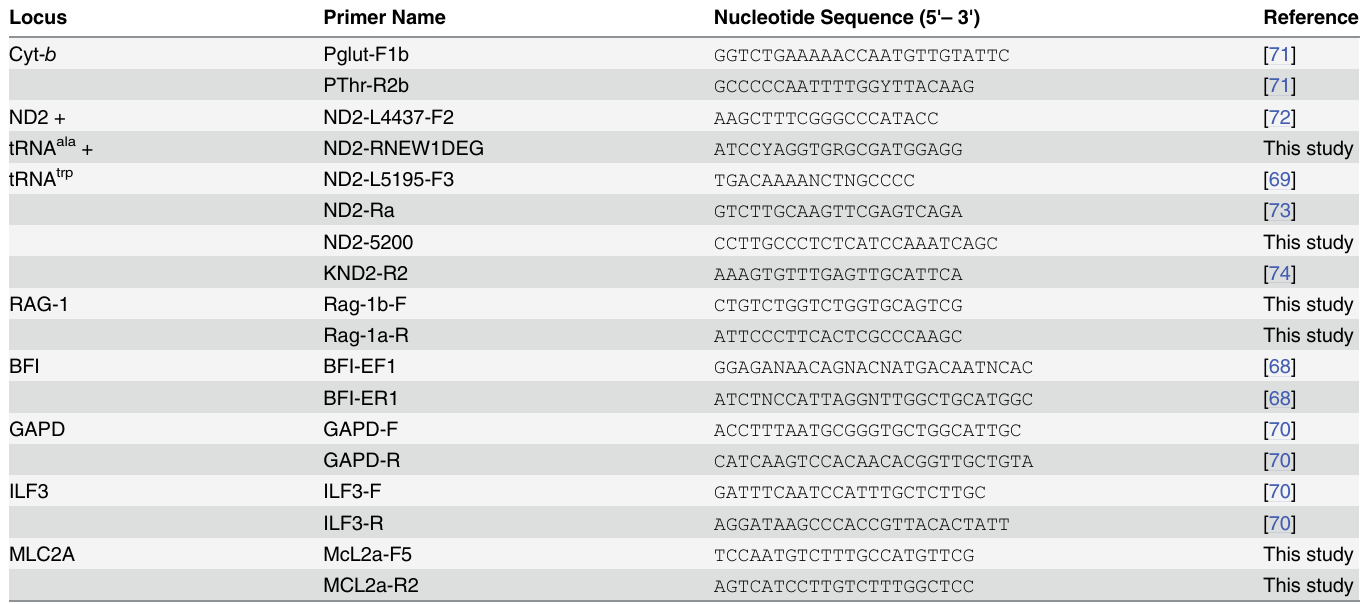
Table 1. Primer sequences for all loci used in the study.